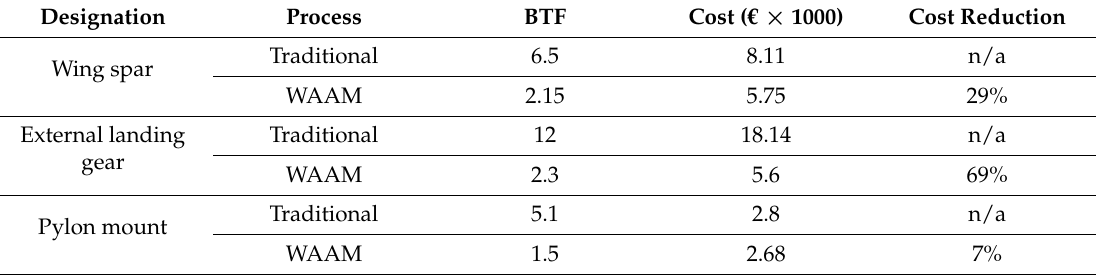
Table 4. Costs of different parts per manufacturing process